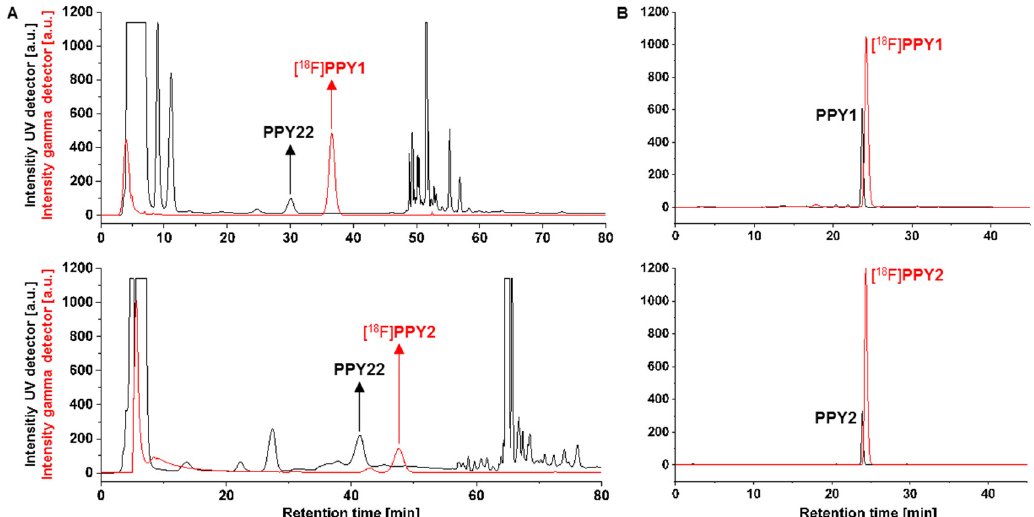
Figure 6. ( A ) Representative radio- and UV-chromatograms obtained for isolation of [ 18 F] PPY1 [ReproSil-GOLD 120 C18 column (250 × 10 mm), 34% MeCN/H 2 O, flow rate: 4 mL/min] and [ 18 F] PPY2 [ReproSil-Pur 120 C18-AQ column (250 × 10 mm), 30% MeCN/H 2 O, flow rate: 5 mL/min] by semi-preparative RP-HPLC ( PPY22 = by-product); ( B ) radio- and UV- chromatograms of formulated [ 18 F] PPY1 and [ 18 F] PPY2 co-injected with the corresponding reference compound PPY1 or PPY2 [ReproSil-GOLD 120 C18 column (250 × 4.6 mm), 10–90–10% MeCN/H 2 O, flow rate: 1 mL/min].